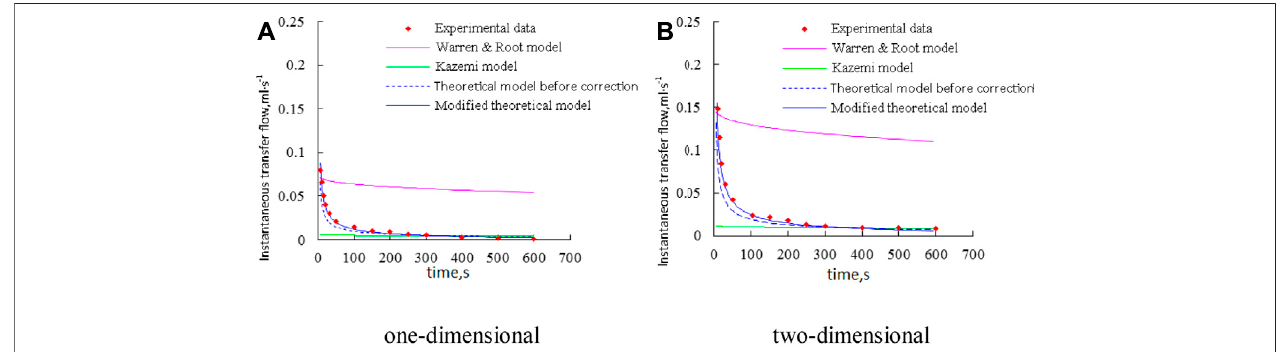
FIGURE 4 | Comparison of the results of the new model of transfer fl ow with the conventional model of instantaneous transfer fl ow in #5 – 12 core.